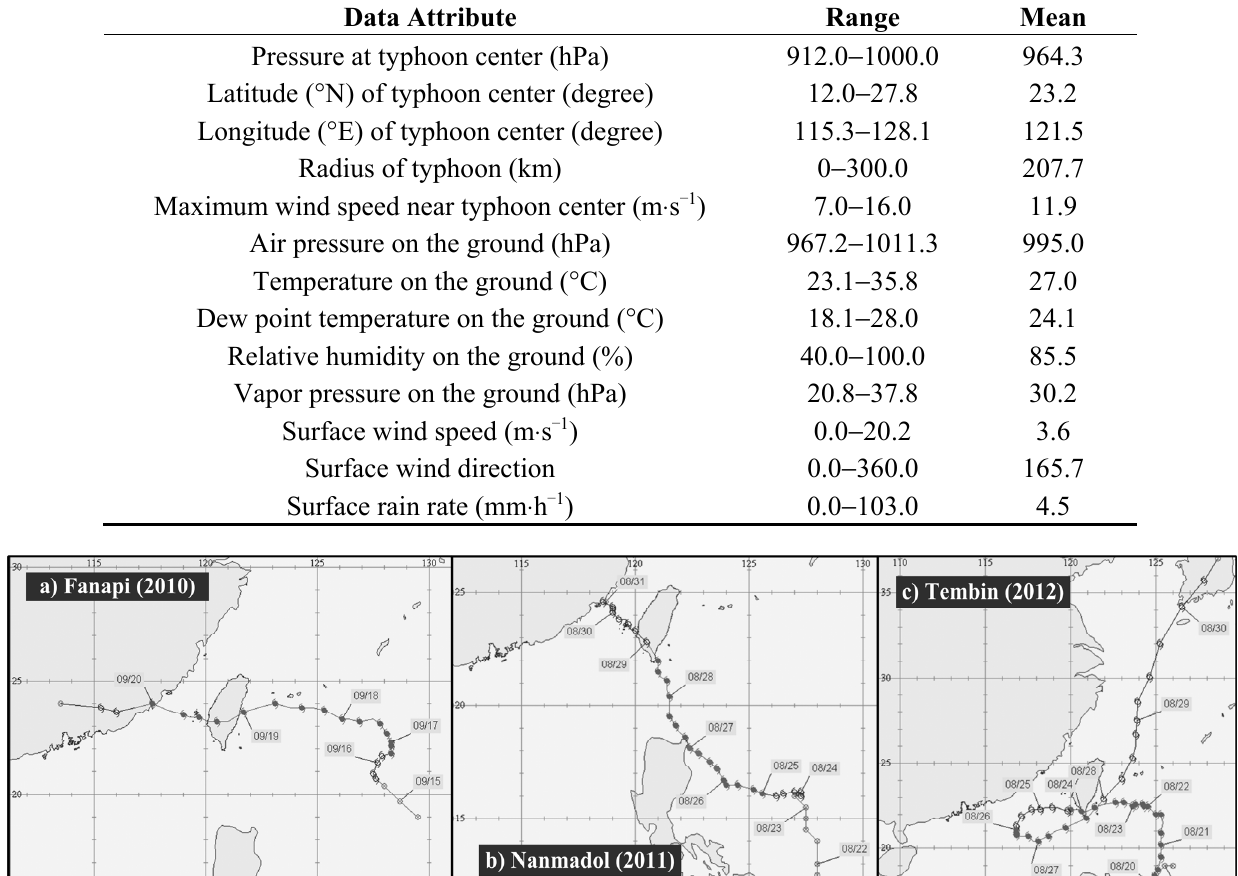
Table 2. Range and average values of data attributes.